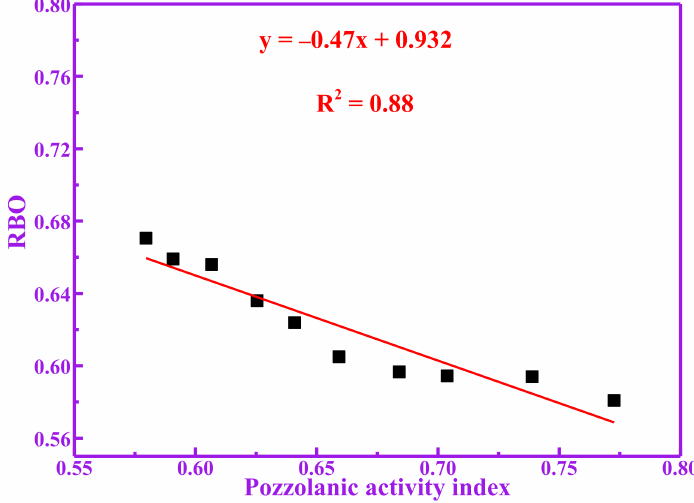
Figure 9. Correlation between RBO and pozzolanic activity